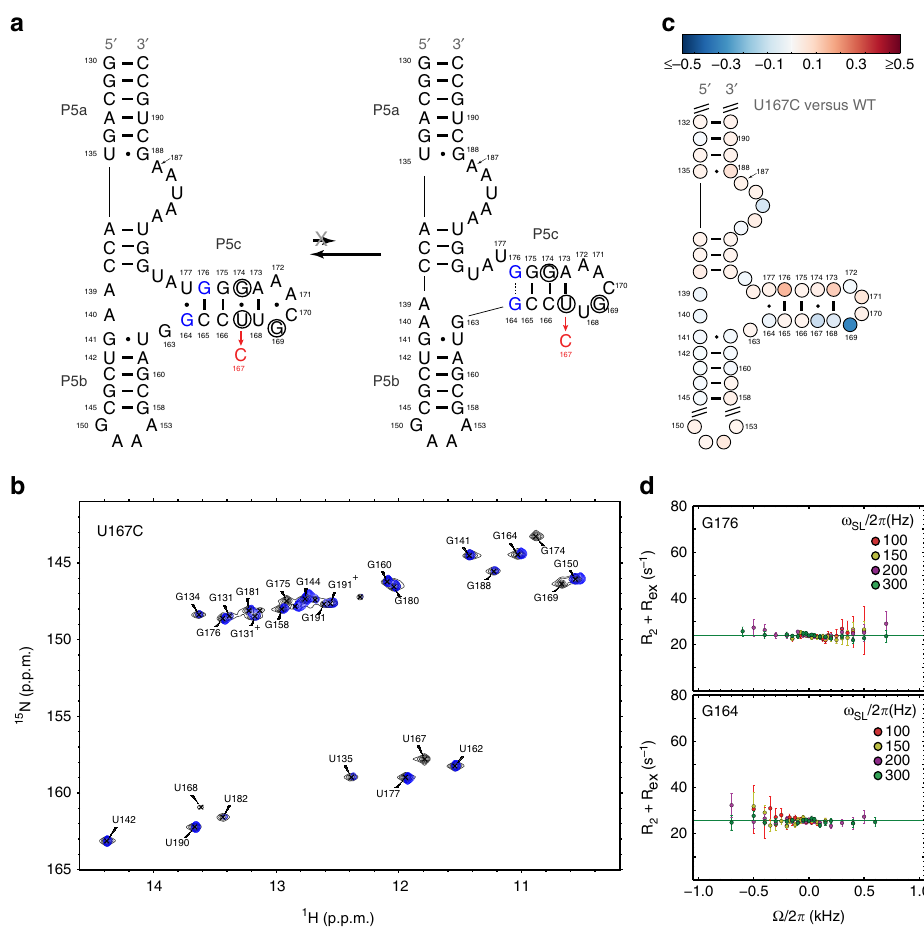
Figure 3 | Analysis of the GS-mutant tP5abc U167C . ( a ) The GS/ES transition is abolished in the GS-stabilizing mutant tP5abc U167C . Residues disappearing or showing large differences in chemical shifts relative to WTare circled in black. Residues G164 and G176 are coloured in blue, indicating no appreciable RD. ( b ) Corresponding 2D 1 H- 15 N HSQC spectrum of tP5abc U167C in 10mM sodium phosphate and 0.01mM EDTA (pH 6.4) at 10 (cid:2) C (blue) overlaid on spectrum of WT tP5abc under the same condition (black). ( c ) Differential SHAPE reactivity measured on tP5abc U167C relative to WT. Red (blue) represents more (less) reactivity, respectively. The data were collected in the absence of Mg 2 þ . ( d ) Off-resonance R 1 r RD profiles measured in tP5abc U167C in the absence of Mg 2 þ